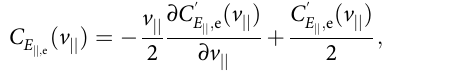
ð v Þ averaged over time; a signature consistent with Landau damping can be jj jj ; e